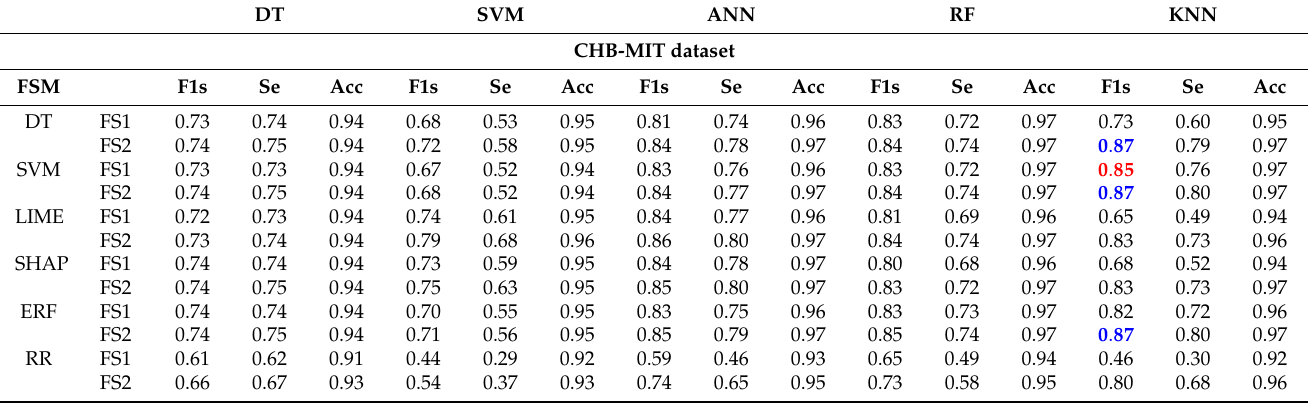
Table 8. Performance comparison using 100 features. The largest F1-scores are displayed in red bold and blue bold for FS1 and FS2, respectively. F1s = F1-score, Se = sensitivity, Acc =